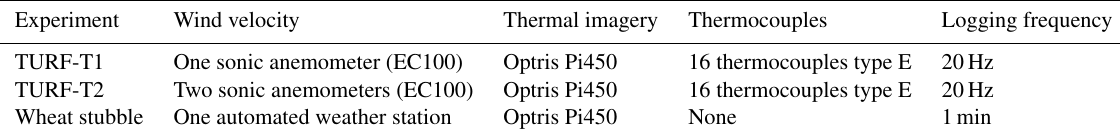
Table 2. Overview of the instrumentation. Experiment Wind velocity Thermal